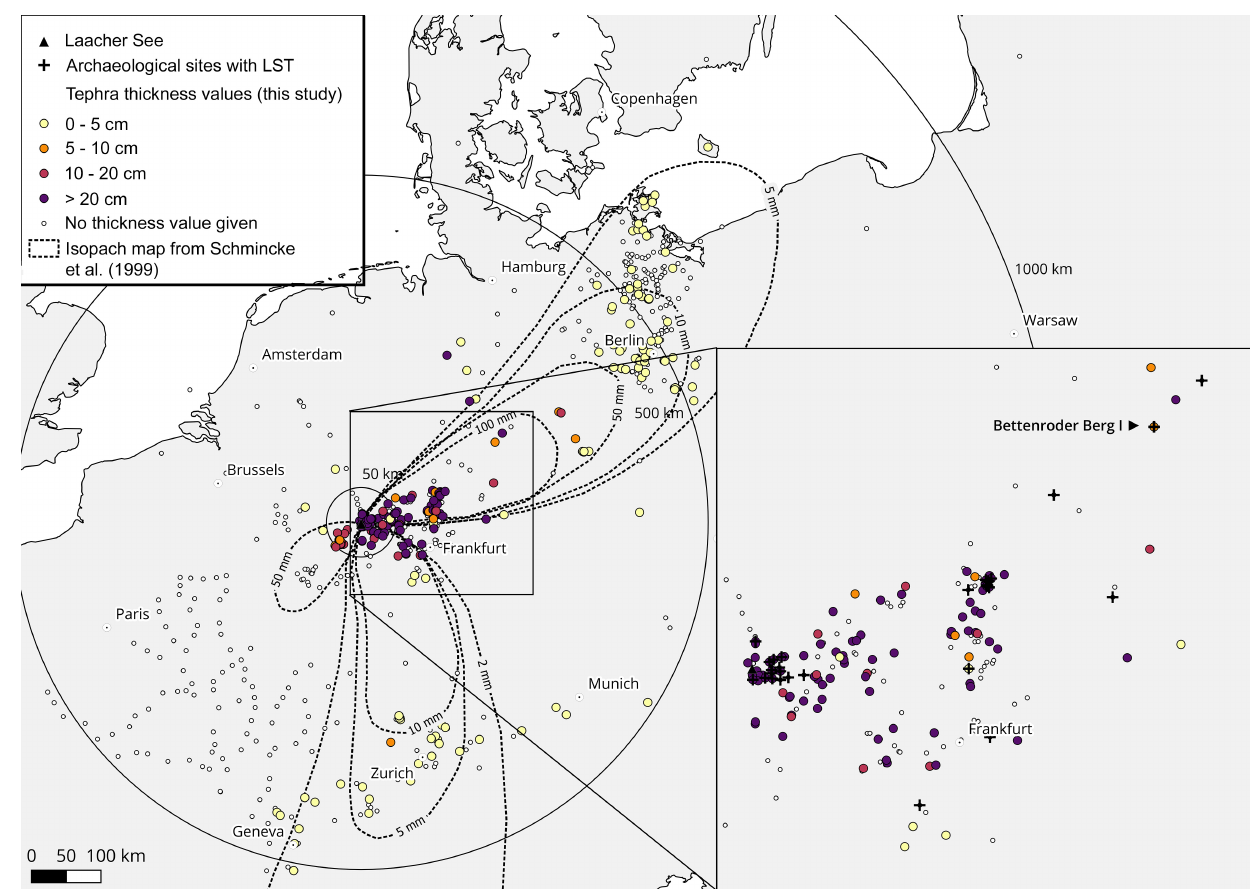
Figure 1: Late Glacial palaeogeograhic map showing the currently known extent of the Laacher See tephra fall in Europe. White dots mark locales where Laacher See tephra is found in association with Federmessergruppen archaeology. The concentric circles mark the division into the proximal (0–50 km), medial (50–500 km), distal (500–1000 km), and ultra-distal ( > 1000 km) hazard